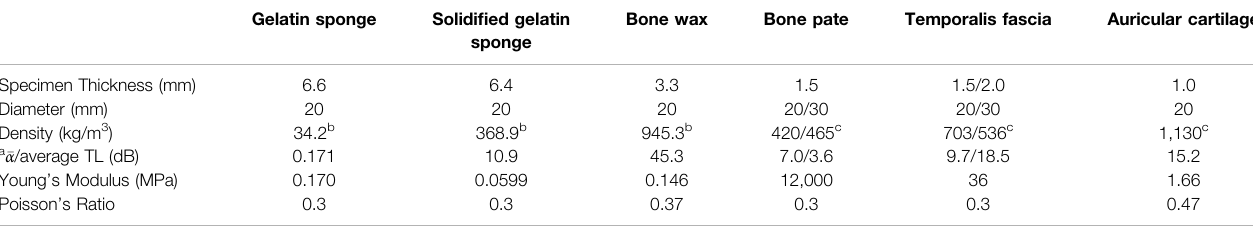
TABLE 1 | The acoustical and mechanical properties of grafts and